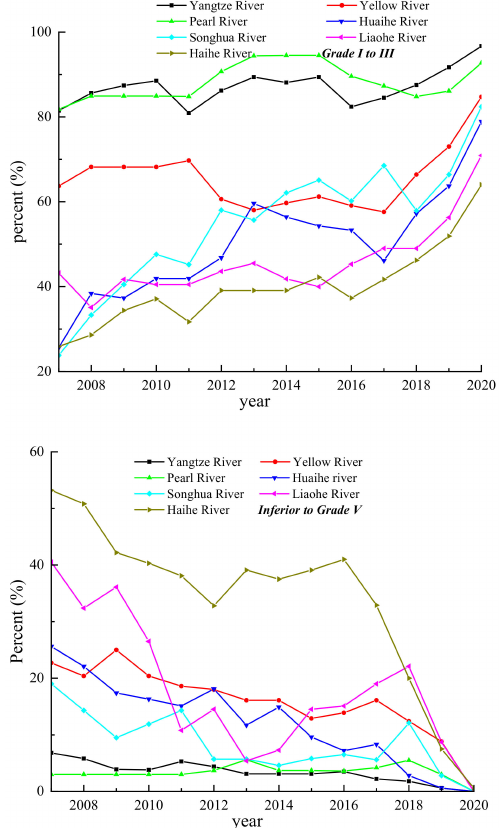
Figure 4. Changes of water quality in the major river basins during